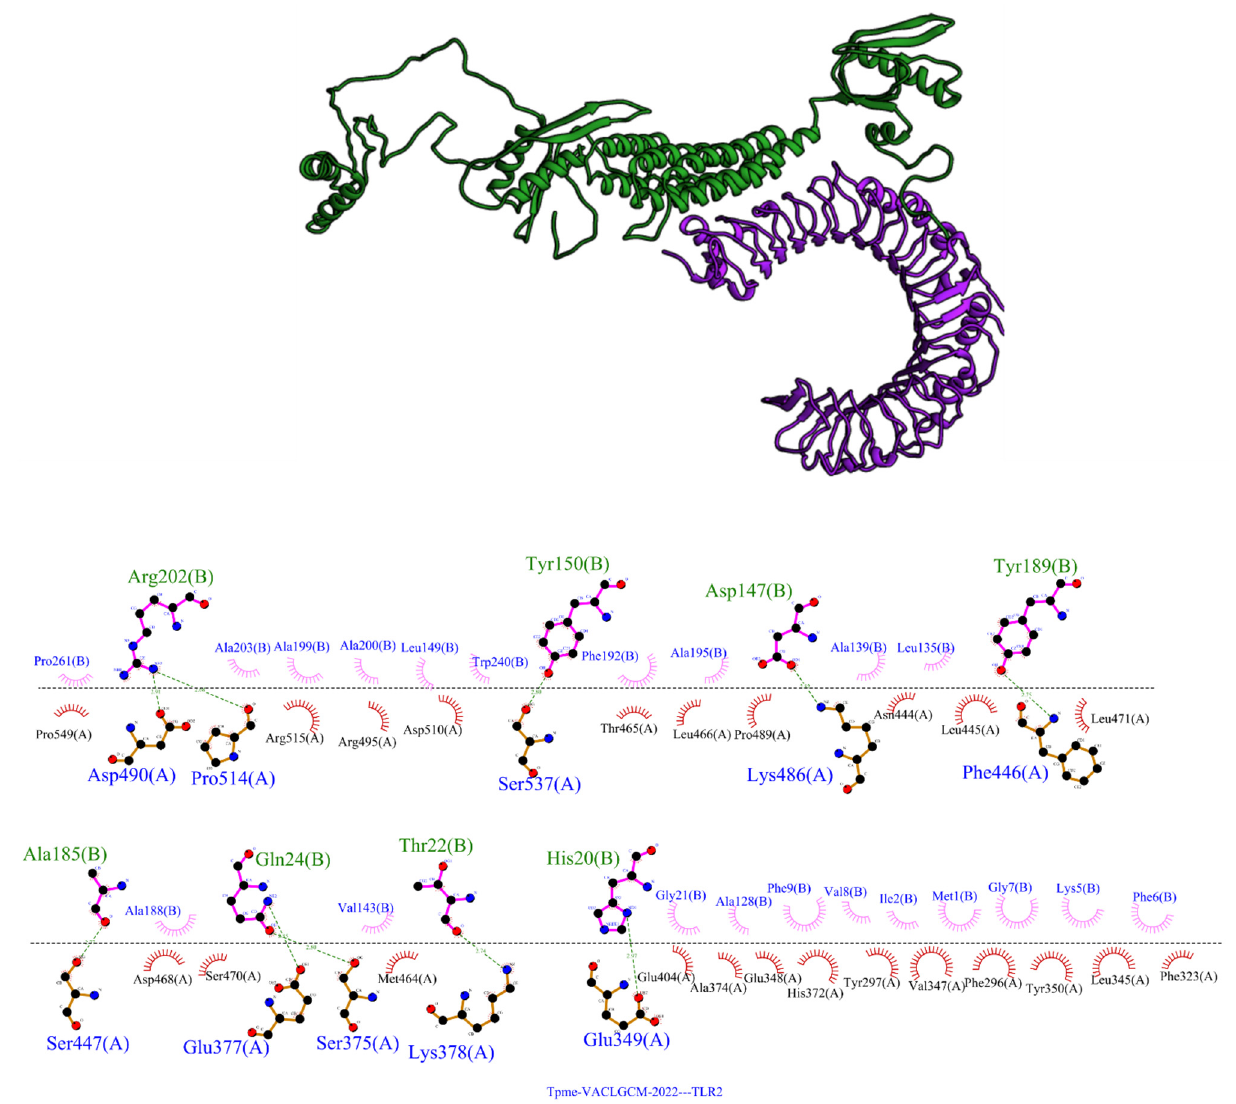
Figure 2. Molecular docking of the Tpme-VAC/LGCM-2022 with the TLR-2 receptor structure representing the interaction with the lowest energy score. 3D structure of the complex. In green, the chimeric protein, and purple is the TLR-2. 3D structure of the complex, highlighting 2D representation of the interactions between TLR 2 and the chimeric protein. The figure represents the residues of the chimeric protein (Chain-B) and TLR2 receptor (Chain-A) with hydrogen bonds (green dotted lines). The residues involved in hydrophobic interactions are shown (Red).